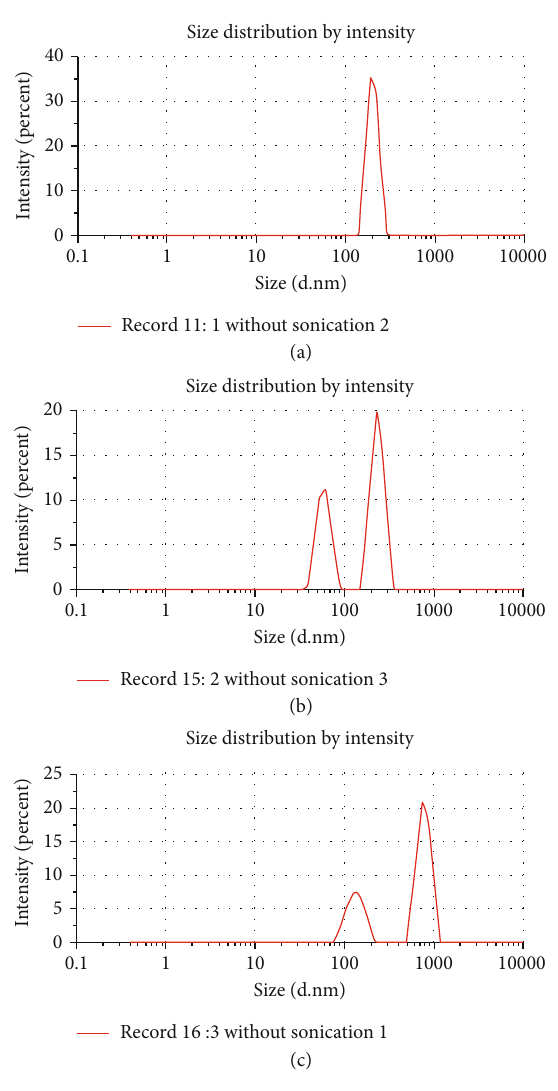
Figure 1: (a – c) Particle size distribution of chickpea fl our (BF), wheat fl our (WF), and whole wheat fl our (WWF) measured by dynamic light scattering, Table 2. The replacement of WF with BF signi fi cantly increased the FN value at all levels. A similar trend was observed when WWF was replaced with varying levels of BF. FN values were found to be signi fi cantly lower ( p < 0 : 05 ) for WWF than both the WF and BF, and no signi fi cant dif- ference was observed between WF and BF. The FN values are a ff ected by the fl our granulation, type of sprout damage